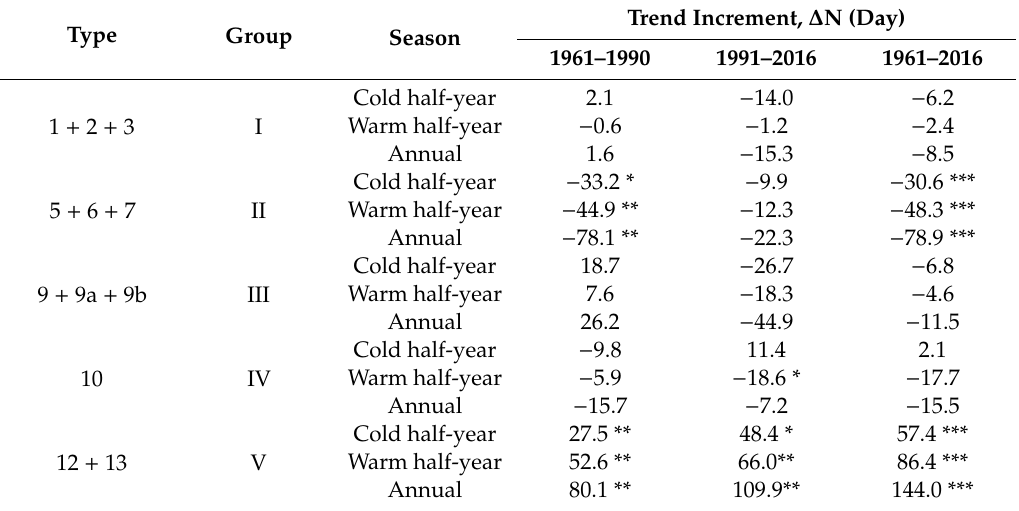
Table 2. Characteristics of trends in the total duration of groups of SWT in Middle Asia. Type